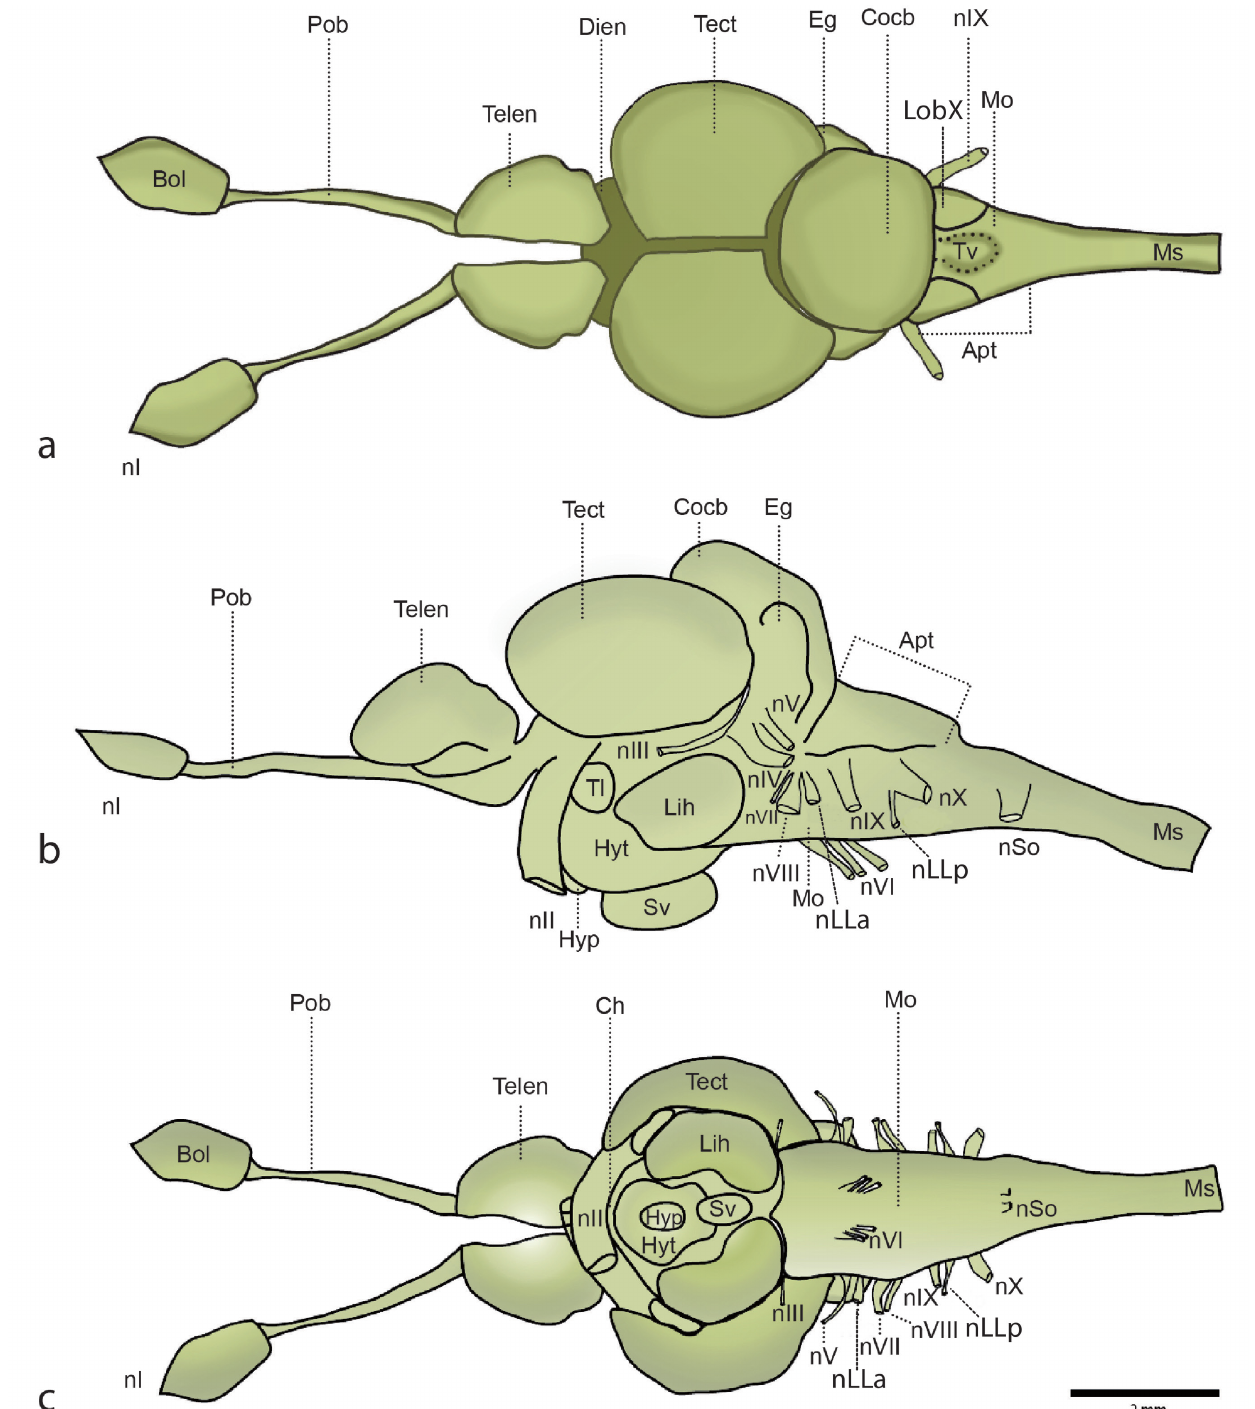
Fig. 2. Brain of Brycon orbignyanus (Characiformes: Bryconidae), LIRP 6309, 175.5 mm SL. a. dorsal; b. lateral and c. ventral views. Apt = Area postrema ; Bol = bulbus olfactorius ; Ch = chiasma opticum ; Cocb = corpus cerebelli ; Dien = diencephalon ; Eg = eminentia granularis ; Hyp = hypophysis ; Hyt = hypothalamus ; Lih = lobus inferior hypothalami ; LobX = lobus vagi ; Mo = medulla oblongata ; Ms = medulla spinalis ; Pob = nervus tractus olfactorius ; Sv = saccus vasculosus ; Tect = tectum opticum ;; Telen = Telencephalon Tl = Torus lateralis ; Tv = tela ventriculi ; Cranial Nerves : nI = nervus olfactorius ; nII = nervus opticus ; nIII = nervus oculomotorius ; nIV = nervus trochlearis ; nV = nervus trigeminus ; nVI = nervus abducens ; nVII = nervus fascialis ; nVIII = nervus octavus ; nLLa = nervus lineae lateralis anterior ; nLLp = nervus lineae lateralis posterior ; nIX = nervus glossopharyngeus ; nX = nervus vagus and; nSo = nervus spino-occipitales